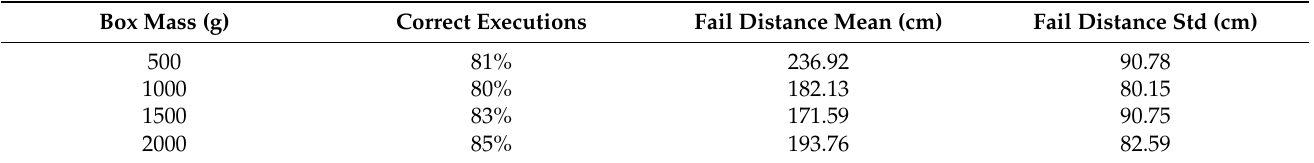
Figure 8. Environment of 500 × 500 cm with three robots and three boxes that needed to be located and transported to the home zone (goal). The figure presents the trace of each of the robots in the swarm. The origin of the swarm is indicated by the white point, surrounded by the goal zone (in blue). It is shown how the swarm was able to move towards the boxes and push them to the goal. Table 2. Policy tests for boxes of different weights. For each weight, 100 executions of the behavior were carried out. If the box did not reach the goal in 700 iterations, then the test was marked as incorrect. For all incorrect tests of each weight, the box–goal mean distance and standard deviation are shown.